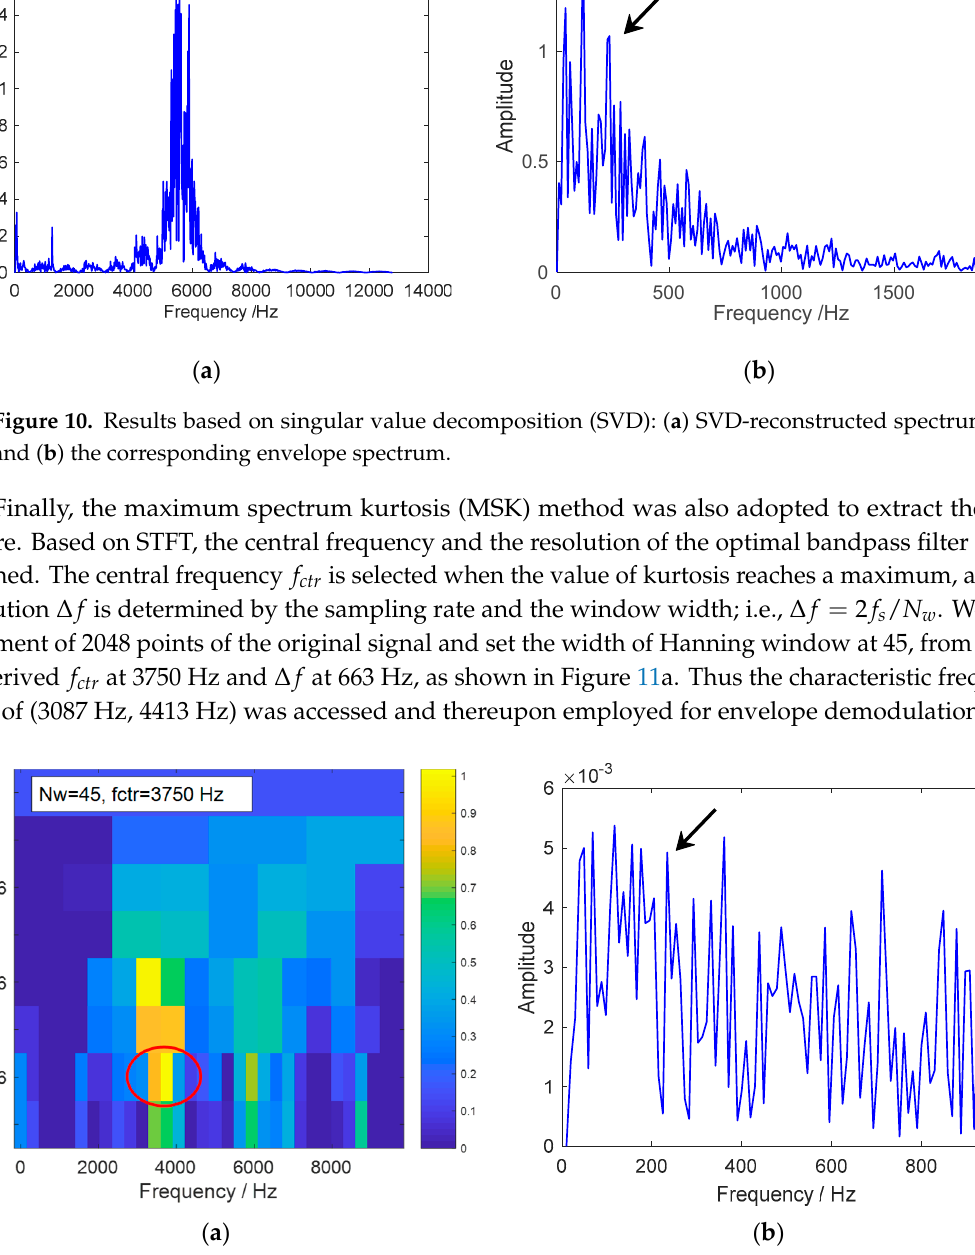
Figure 11. Results based on maximum spectrum (MSK): ( a ) Kurtogram of the signal; ( b ) envelope spectrum of the filtered signal.